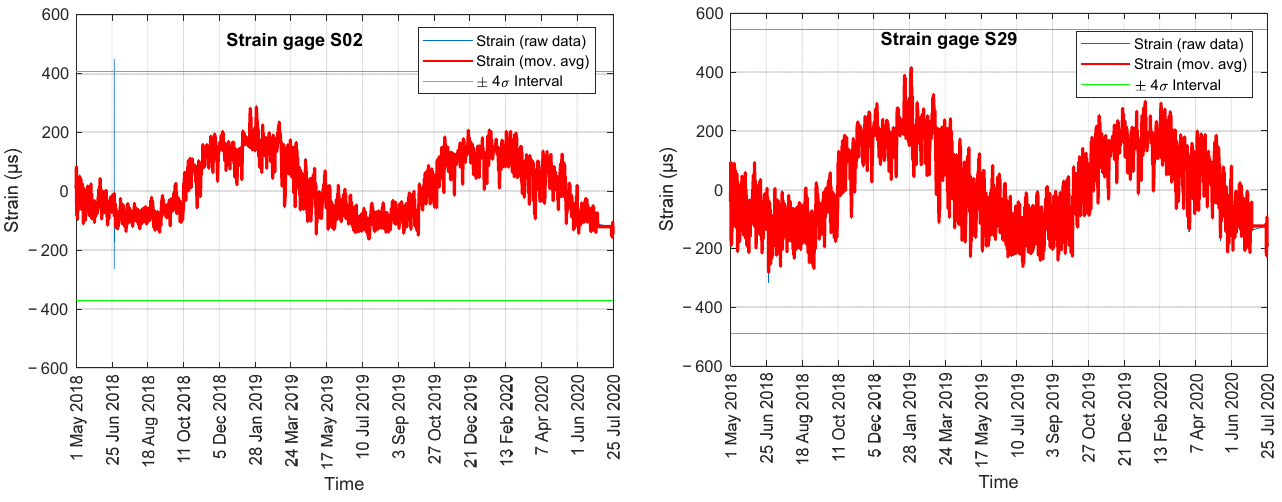
Figure 10. Raw strain and corresponding 15 min moving average recorded by gauges S02 and S29. Figure 11a shows the raw temperatures recorded by the temperature gauge embedded with the strain sensor S02. The graphs present the same spike on 28 June 2018, which suggest that it was caused by some electromagnetic interference that affected the whole system. A few days of January 2019 were extremely cold as confirmed by the temperatures shown in Figure 11b recorded by a near (Johnstown-Cambria Co.) weather station (https://www.wunderground.com/history/monthly/us/pa/johnstown/KJST/date/2019-1, accessed on 10 April 2022).